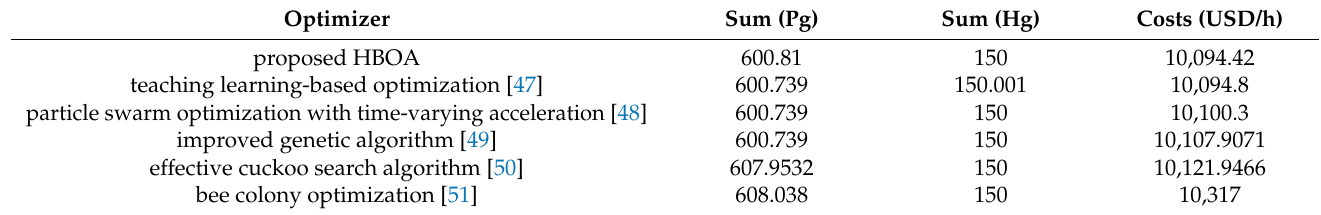
Table 7. Comparisons between the proposed HBOA and other reported techniques of Case 2 at the